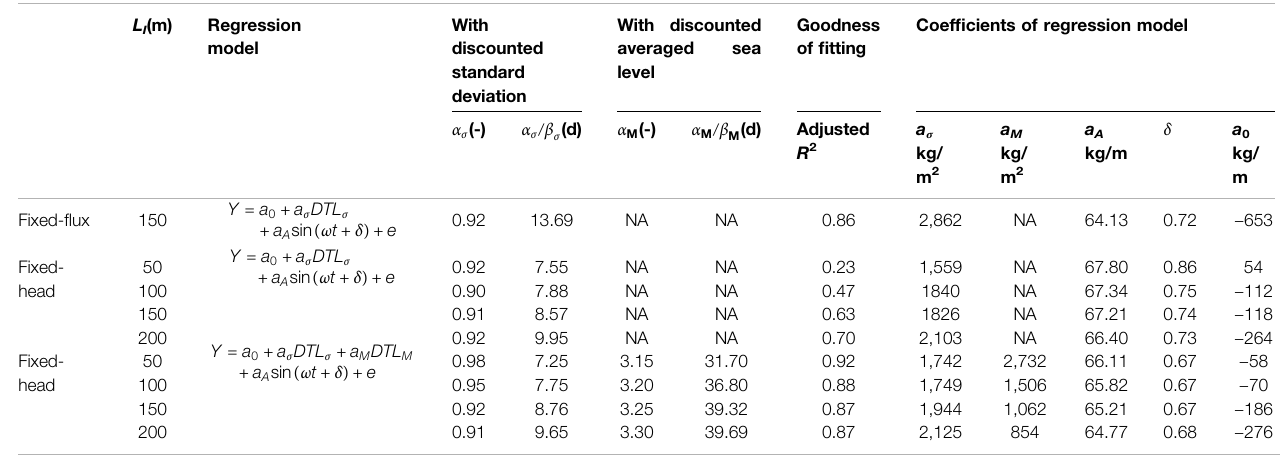
TABLE 5 | Summary of regression results for SM USPa .